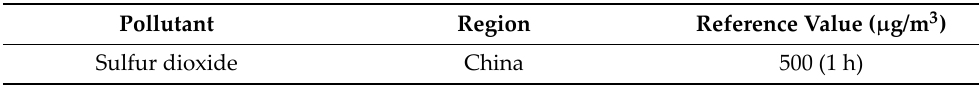
Table 24. Reference values for sulfur dioxide.